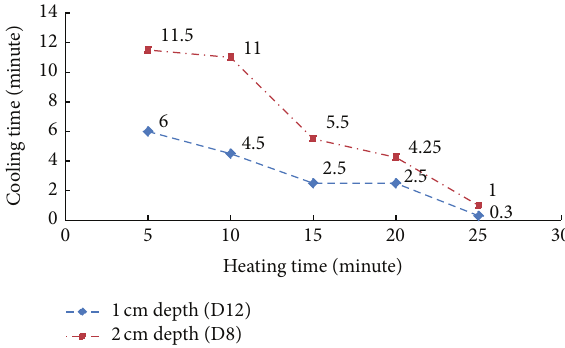
Figure 8: Heating and cooling time relationship for delaminations with the size of 10 × 10cm at 1 and 2cm in depth.